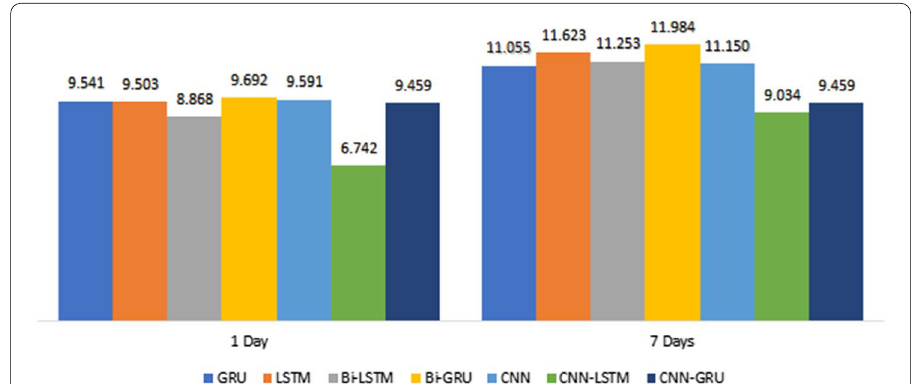
Fig. 13 Comparison of the MAE for the 1day and 7day lag for the different deep learning